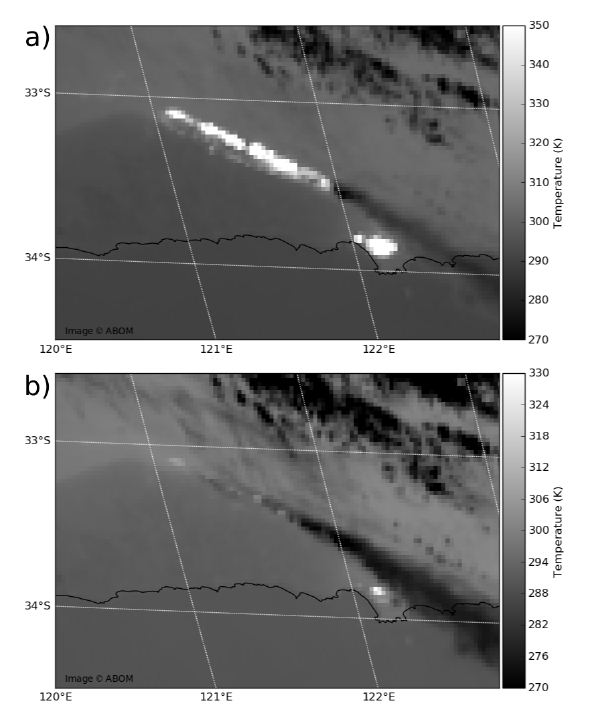
Figure 2: AHI-8 brightness temperature image of the North Cas- cade and Merivale fires, Esperance region of Western Australia, 2015-11-17 1000 UTC (1800 AWST). a) Band 7 - 3.9 µ m b) Band 13 - 10.8 µ m © ABOM 2015